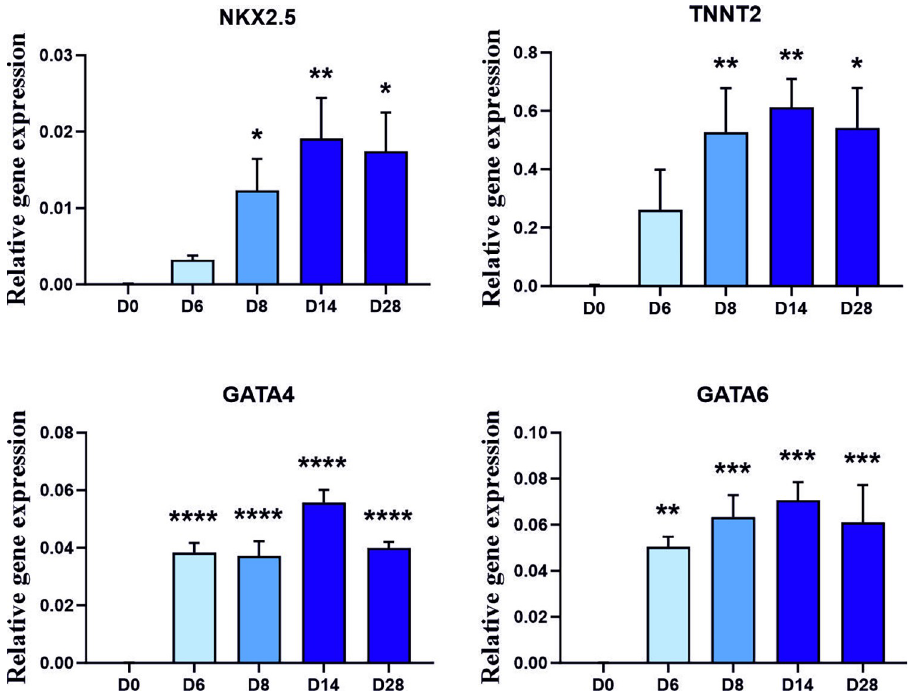
Fig 5. Differentiation of cardiomyocyte progenitor cells from lateral plate lineage through cardiac mesoderm. Gene transcriptional analysis of cardiomyocyte genes during differentiation to beating cardiomyocytes. (For video of contracting tissue please see supplementary evidence). Gene expression data displayed relative to housekeeping gene GAPDH +SEM. Mann-Whitney test was used to determine statistical significance. Significance relative to hPSCs (day 0) (+ � 0.05, ++ � 0.01) (N = 5 independent experiments for days 0 to 14, N = 4 for day 28).